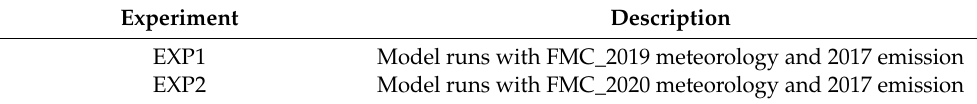
Table 2. The descriptions of sensitive experiments.